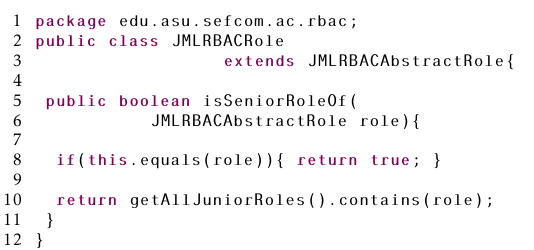
Figure 5. AnExcerptof a JML Model Class Depictingan ANSI RBAC Role Component.